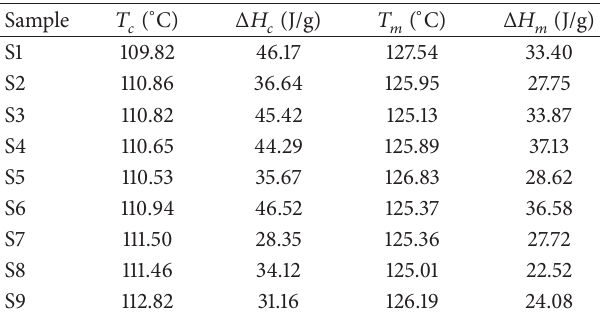
Figure 2: Heating and cooling thermograms of control and blend samples with NIR reflective and other UV additives. Table 5: Thermodynamic properties of control resin and blend